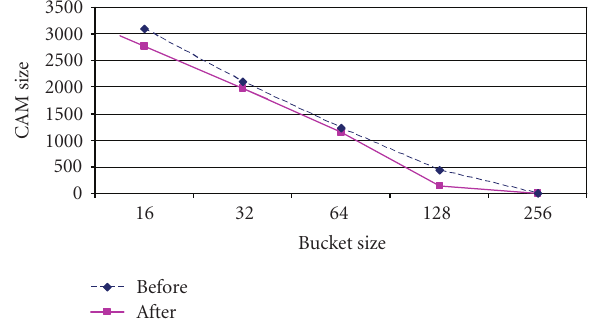
Figure 15: The e ff ect on the CAM size of moving the largest 10% of the